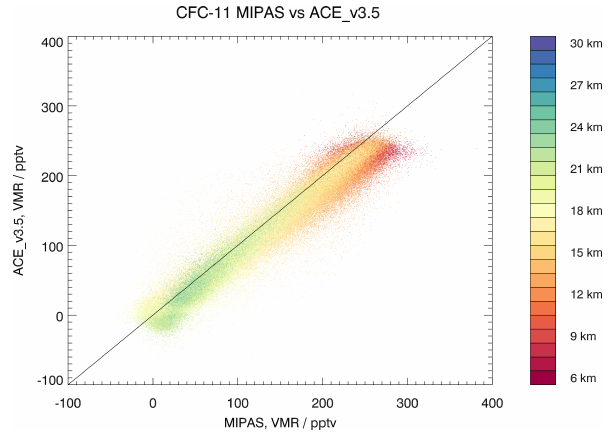
Figure 9. Correlation of collocated MIPAS CFC-11 measurements with ACE-FTS measurements during the time period of 2005 to 2012.